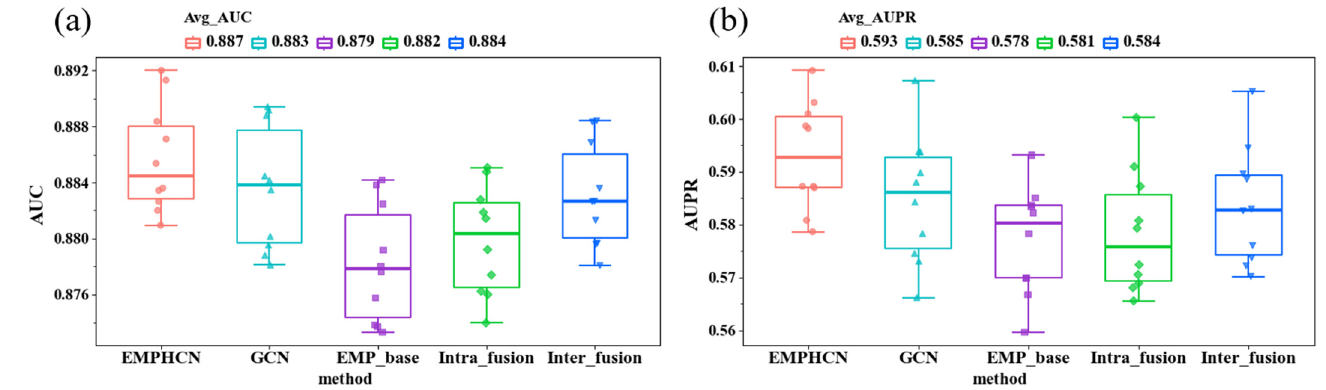
Figure 3. Comparison with 10-fold cross-validation for different variants of EMPHCN on dataset T1. ( a ) AUC comparison of different variants of EMPHCN. ( b ) AUPR comparison of different variants of EMPHCN.